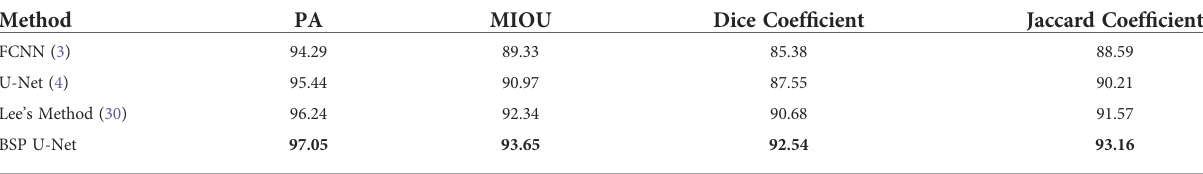
TABLE 3 Evaluation of U-Net, FCN, Lee ’ s network, and the proposed network on prostate ultrasound images. Method